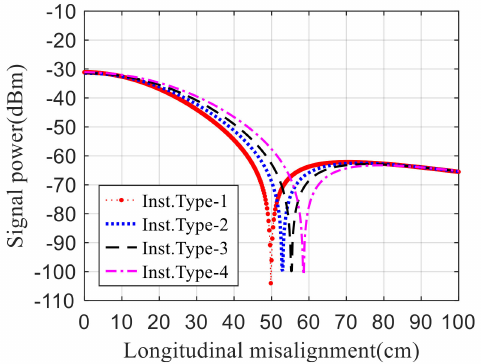
Figure 17. Variation of uplink received signal power with different installation modes (active balise).